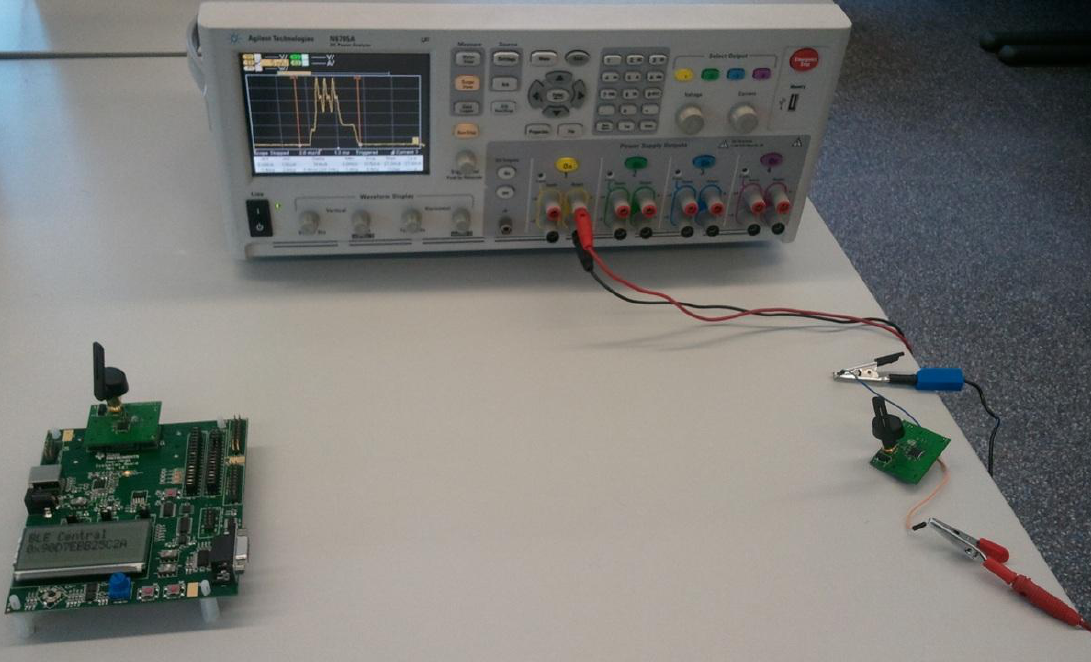
Figure 3. Experimental setup used for measuring the current consumption of a CC2540 slave. The devices on the left and on the right of the picture are configured as the master and the slave, respectively. The slave is connected to the power analyzer. (Note: the screen of the power analyzer shows the current consumption due to the transmission of the three advertising packets of an advertising event (see Subsection